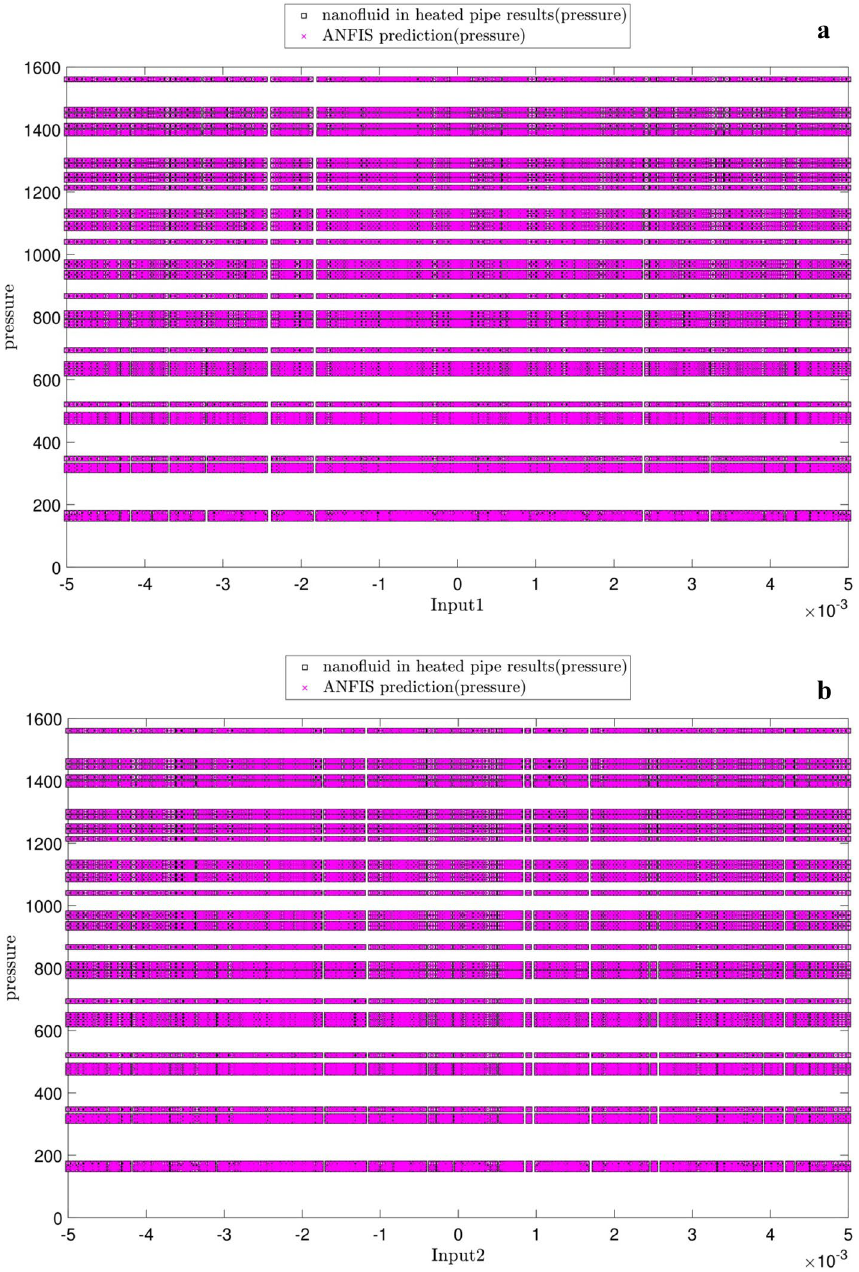
Figure 10. ( a ) Relation between pressure as output and x-direction as first input. ( b ) Relation between pressure as output and y-direction as second input. ( c ) Relation between pressure as output and z-direction as third input. ( d ) Relation between pressure as output and nanofluid fraction as fourth input. ( e ) Relation between pressure as output and temperature as fifth